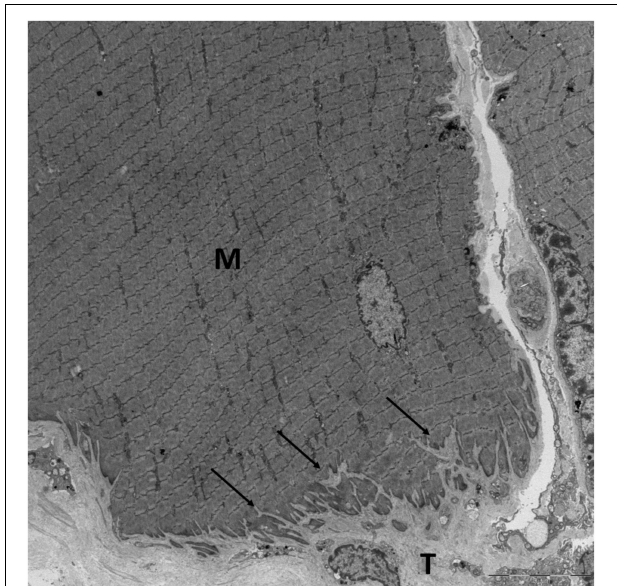
FIGURE 1 | The MTJ of a human semitendinosus muscle fiber viewed with EM. The protrusions (arrows) from the tendon (T) into the muscle fiber (M) increase the contact area between the muscle and tendon. Scale bar is 10 µ m. Image by Andreas B. Knudsen, made at the Centre for Integrated Microscopy (CFIM) at the Panum Institute in Copenhagen, Denmark, used by